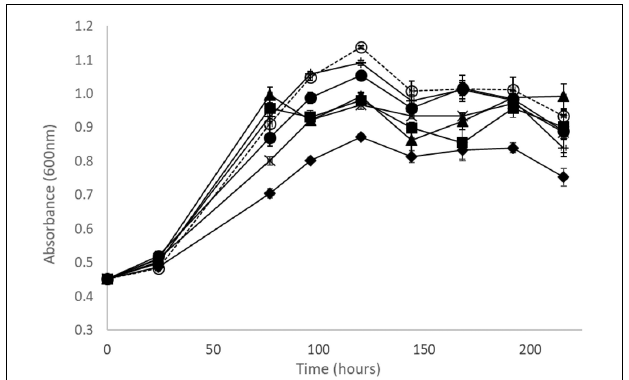
FIGURE 2 | Growth curves of O. oeni OenosTM in MRS broth medium (pH 4.5, 5% v/v ethanol at 25 ◦ C with no agitation in aerobic conditions) supplemented with